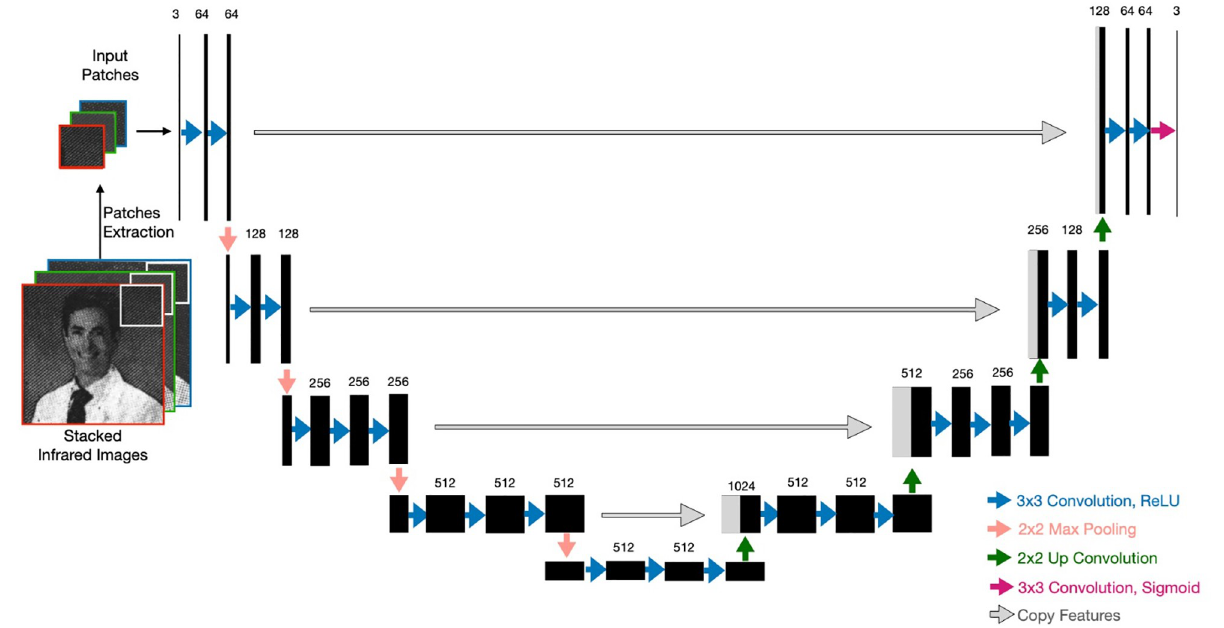
Fig 3. U-Net architecture for infrared colorization. The number of channels is reported on the top of the feature maps. The arrows represent different types of